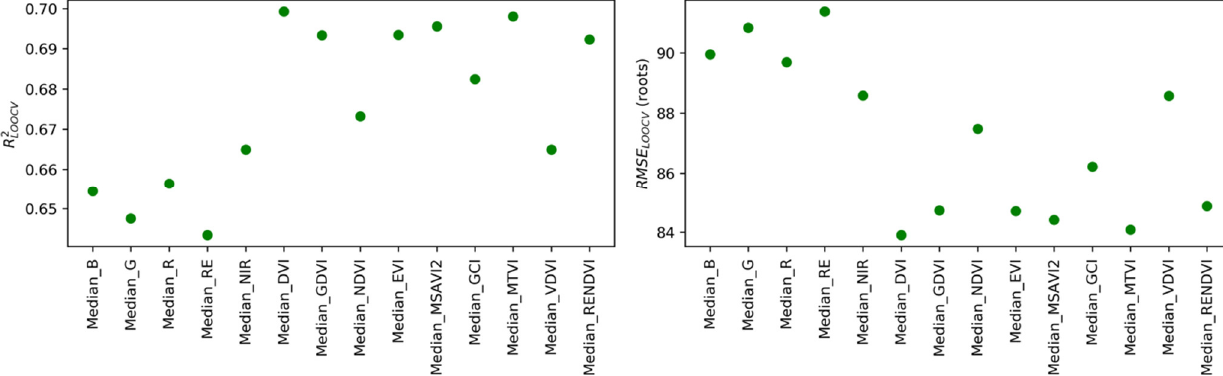
Figure 7. Measured vs. predicted table beet root count for the 2018 emergence DVI + Area multiple linear regression model, based on area-augmented imagery ( left ). The model is trained with 90% (red) and tested with the remaining 10% (green) area augmented study plot imagery. RMSE are displayed for the training data using leave-one-out cross-validation and for the unseen test data. The DVI + Area model is trained with 100% of the 2018 emergence imagery and tested to predict the root count (blue) for 100% of the 2019 area-augmented study plot imagery occurring closest to emergence ( right ). We further trained the DVI + Area model using the 2018 area-augmented emergence imagery and tested on the area-augmented imagery from 2019 obtained on 16 July, closest to emergence for that season. The predictions for this model are shown in the right panel of Figure 7. The model underpredicts several of the larger augmented plots with an  = 127 roots or 35% of the mean root count for the 2019 area-augmented plots.